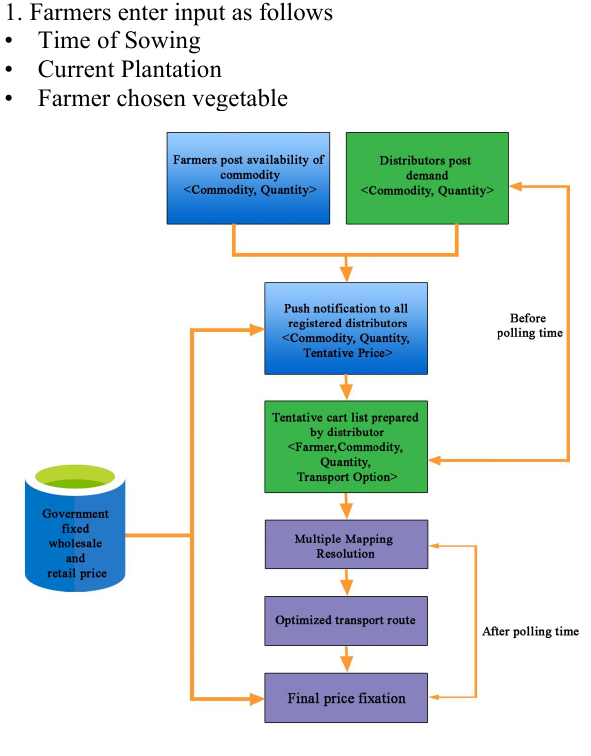
Figure 3. Working Principle of Proposed